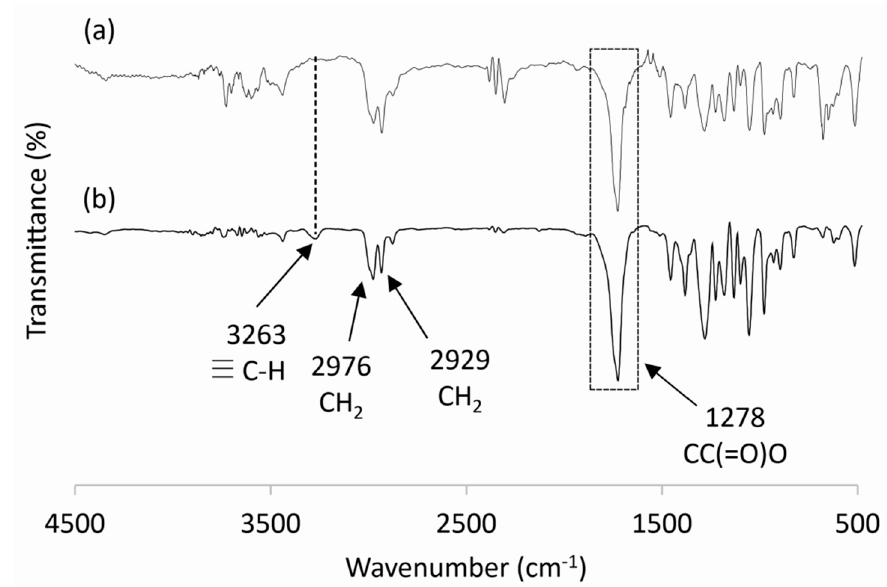
Figure 3. FTIR spectra of unmodified PHBHV ( a ) and PHBHV-alkyne after transesterification with propargyl alcohol ( b ). propargyl alcohol ( b